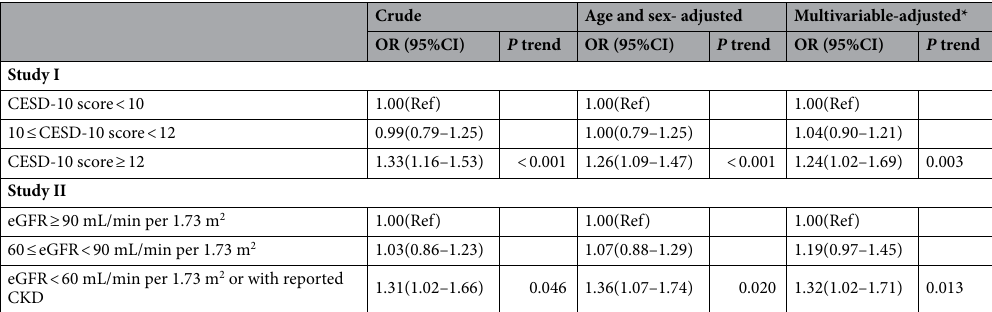
Table 3. Sensitivity analyses of the association between depression and kidney disease. * Multivariable- adjusted for Multivariable-adjusted for age, sex, education level, living place, smoking, drinking, body mass index, systolic blood pressure, and medical history (dyslipidemia, diabetes, cancer, heart disease, stroke, asthma, lung disease, liver disease, digestive disease, and memory problem). † CKD eGFR < 90 mL/min per 1.73 m 2 or with reported kidney diseases.